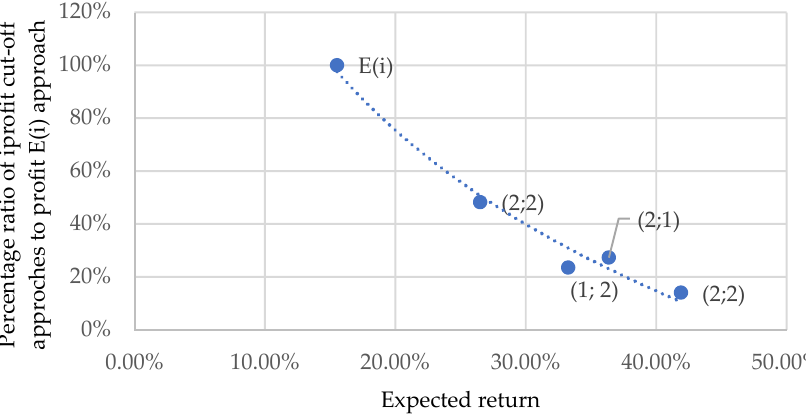
Figure 3. Correspondence between expected returns and expected profits.